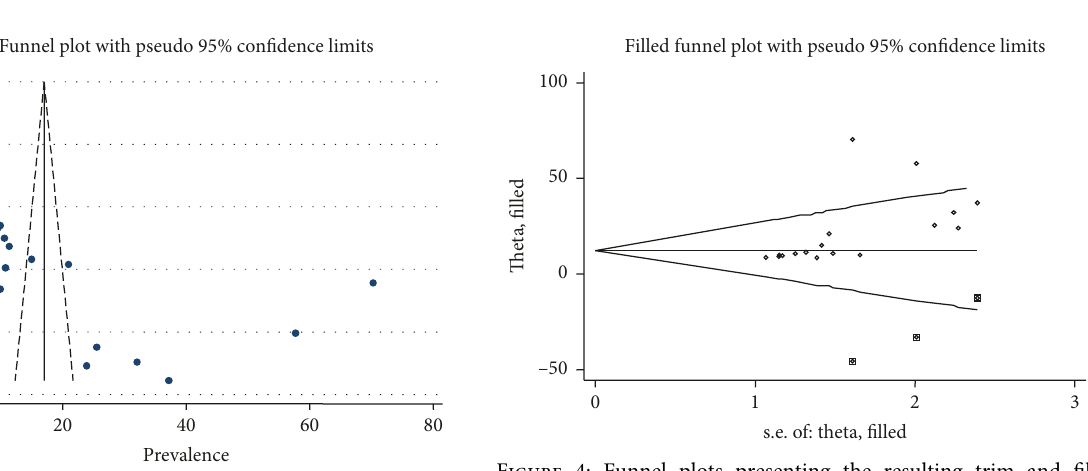
Figure 3: Funnel plot for examining publication bias of appro- priate complementary feeding practices among mothers who had IYC aged between 6 and 24 months.